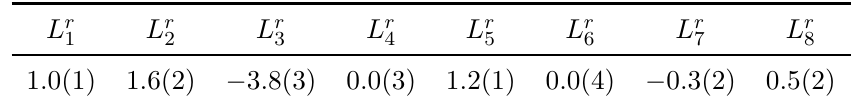
≤ 0 . 3 × 10 3 . The renormalization scale is 4